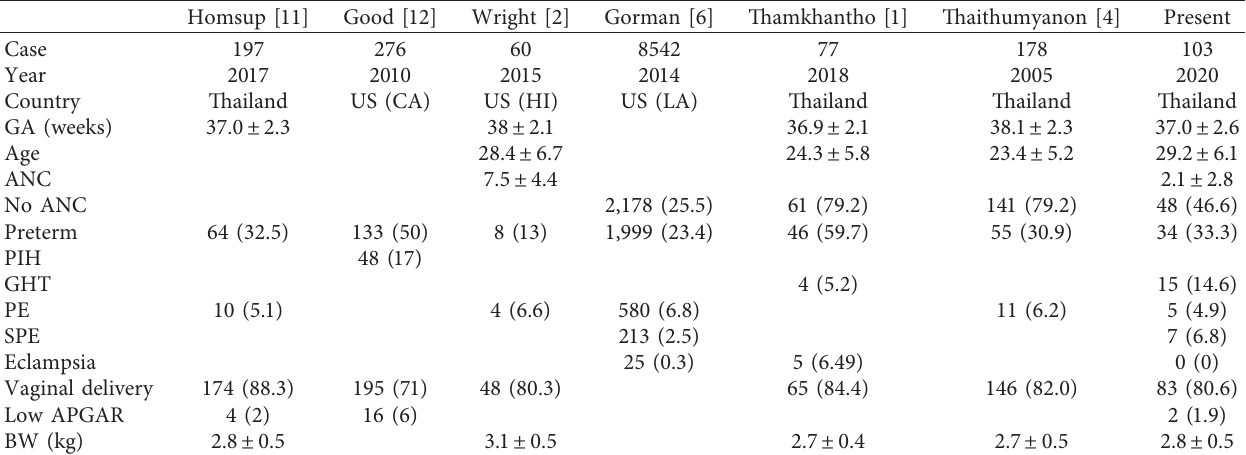
Table 3: The comparison studies in patients’ characteristic and pregnancy